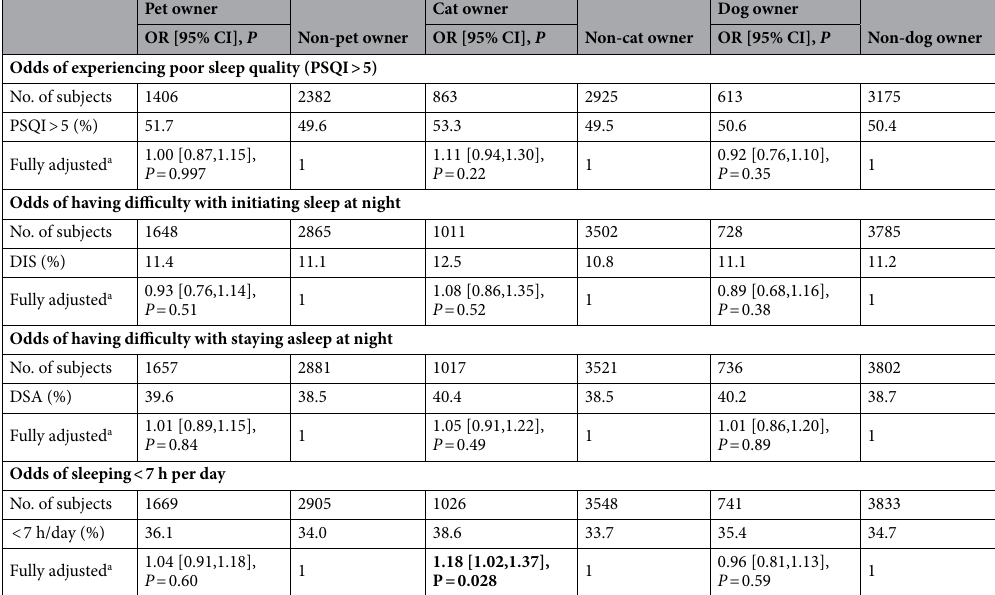
Majority of dog walking About half of dog walking Lesser part of dog